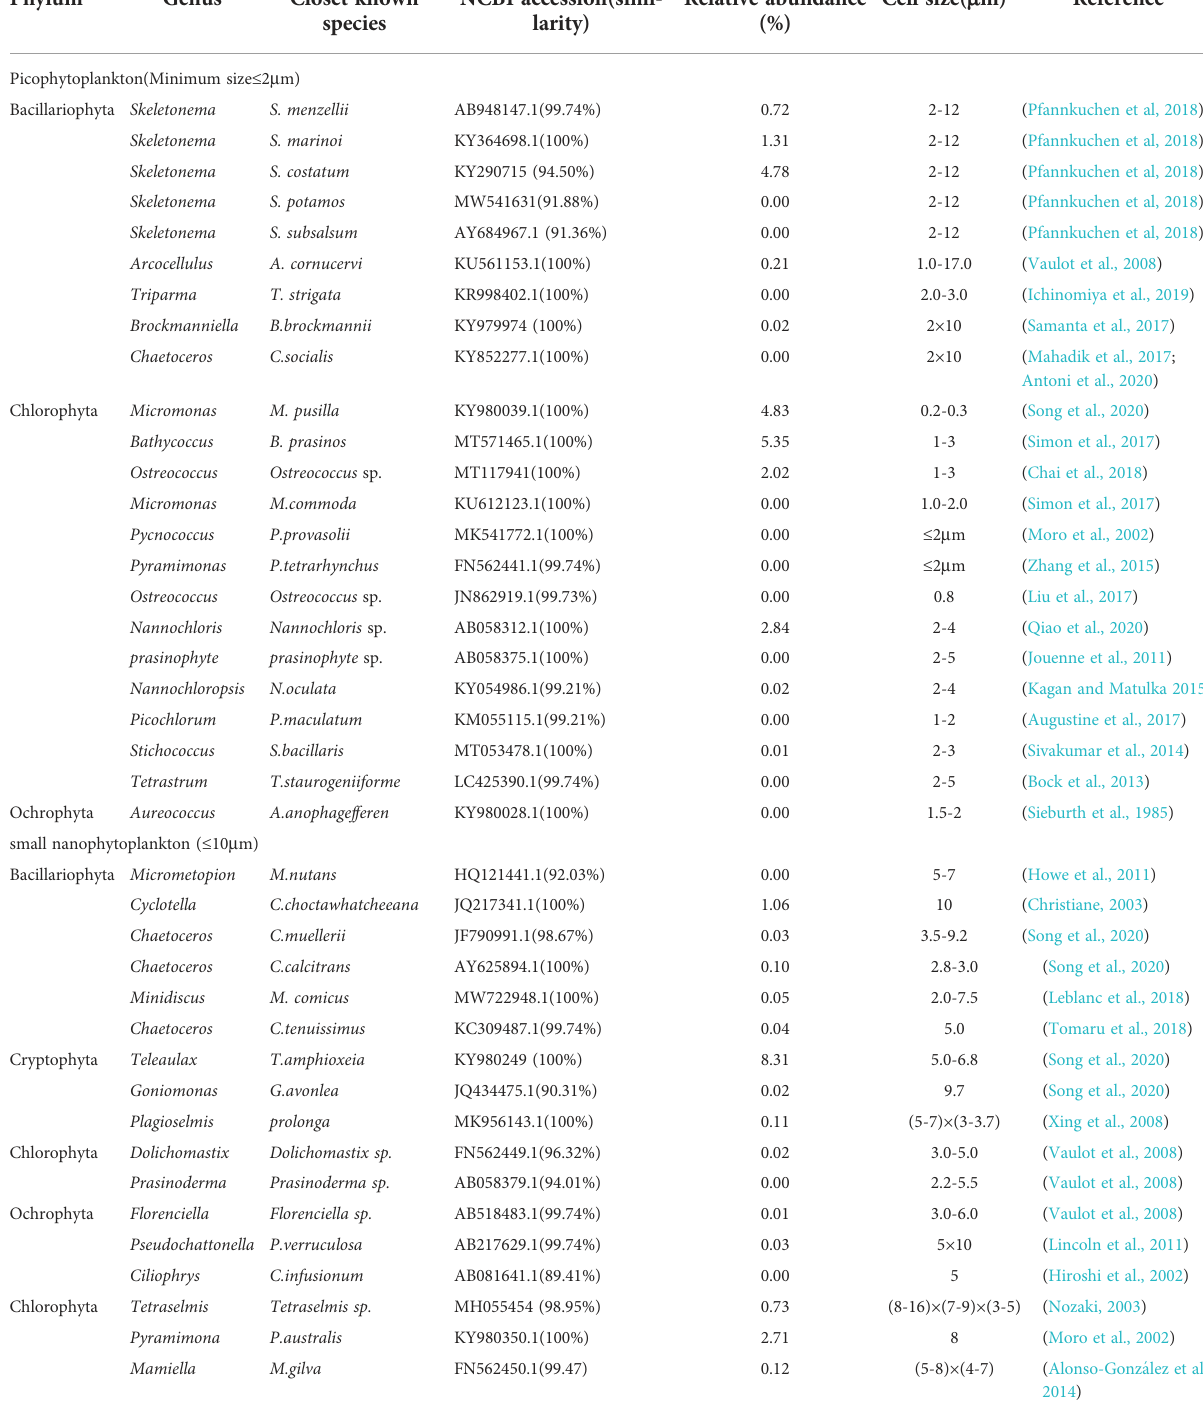
TABLE 2 List of described picophytoplankton and small nanophytoplankton species revealed by high-throughput sequencing. Phylum Genus Closet known